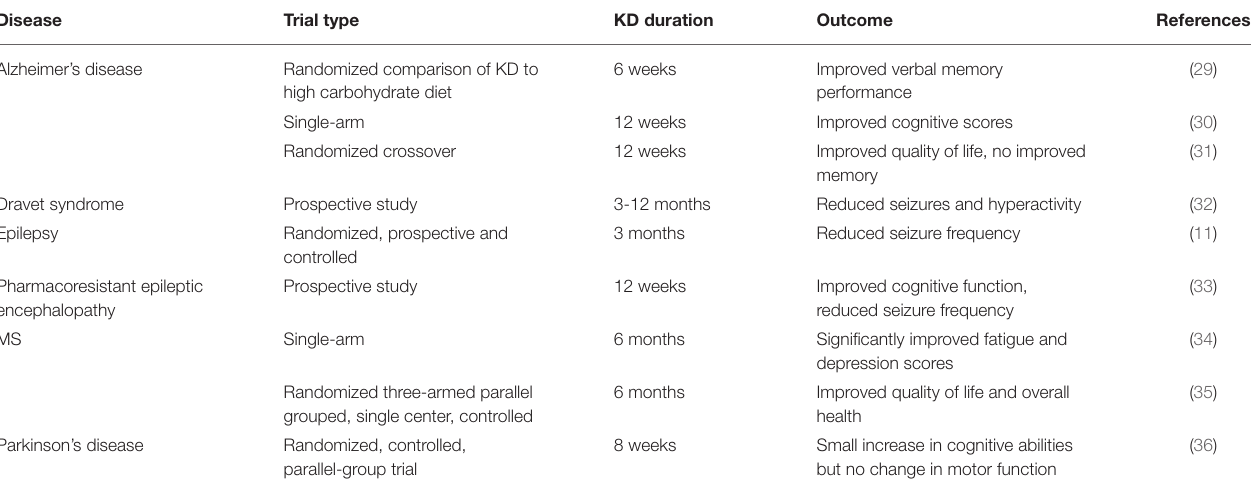
TABLE 2 | Summary of key published clinical studies examining the beneficial effects of the KD in neurological diseases.